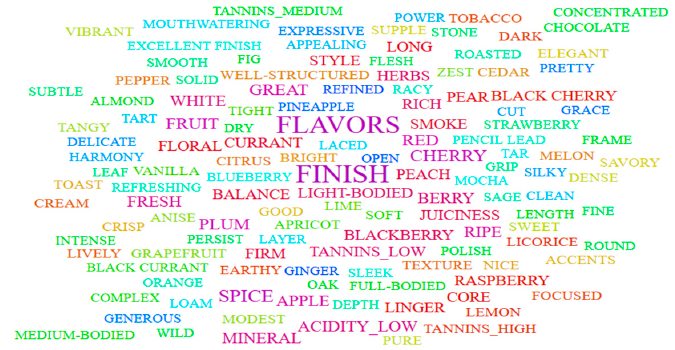
Figure 4. A word cloud of all of the keywords that occur on at least 2000 different wines.